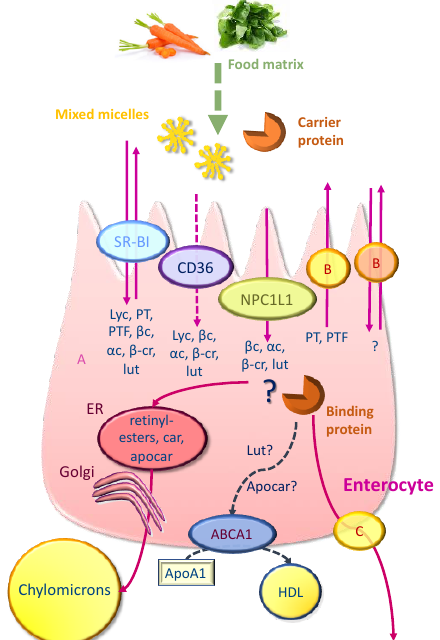
Figure 1. Uptake, transport, and secretion pathways of carotenoids across the enterocyte. PT =